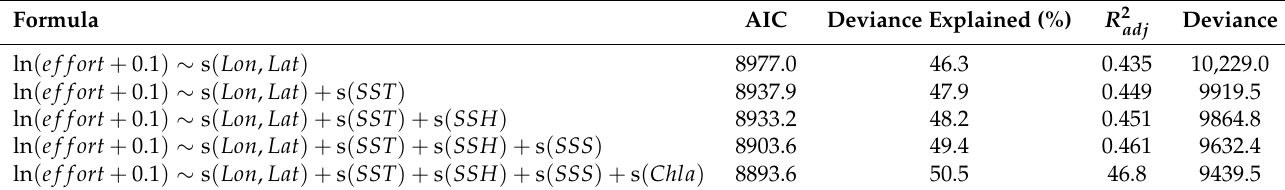
Table 5. Statistical parameters of GAM model (1 ◦ × 1 ◦